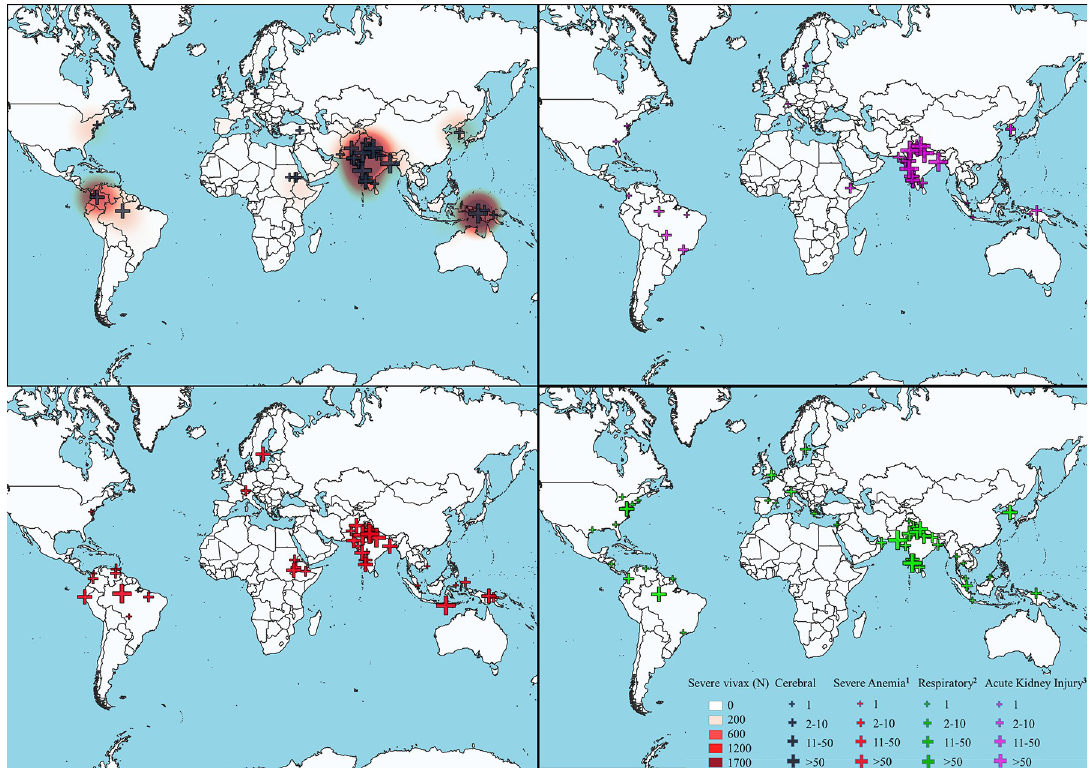
Fig 2. Number of severe vivax cases shown as a heat map with prevalence of severe manifestations using WHO definitions. 1 Hb < 5 g/dl for under 12 years old and < 7 g/dl for above. 2 Pulmonary edema defined by WHO (CXR confirmed or SPO2 < 92% + respiratory rate > 30) or ARDS. 3 Renal failure defined by WHO {plasma or serum creatinine > 265 lM(3 mg/dl) or blood urea > 20 mM}. Map links: https://qgis.org/en/site and https://thematicmapping.org/downloads/world_borders.php. The base layer of the map was downloaded from https://thematicmapping.org/downloads/world_borders.php. ARDS, acute respiratory distress syndrome; Hb, hemoglobin; WHO, World Health